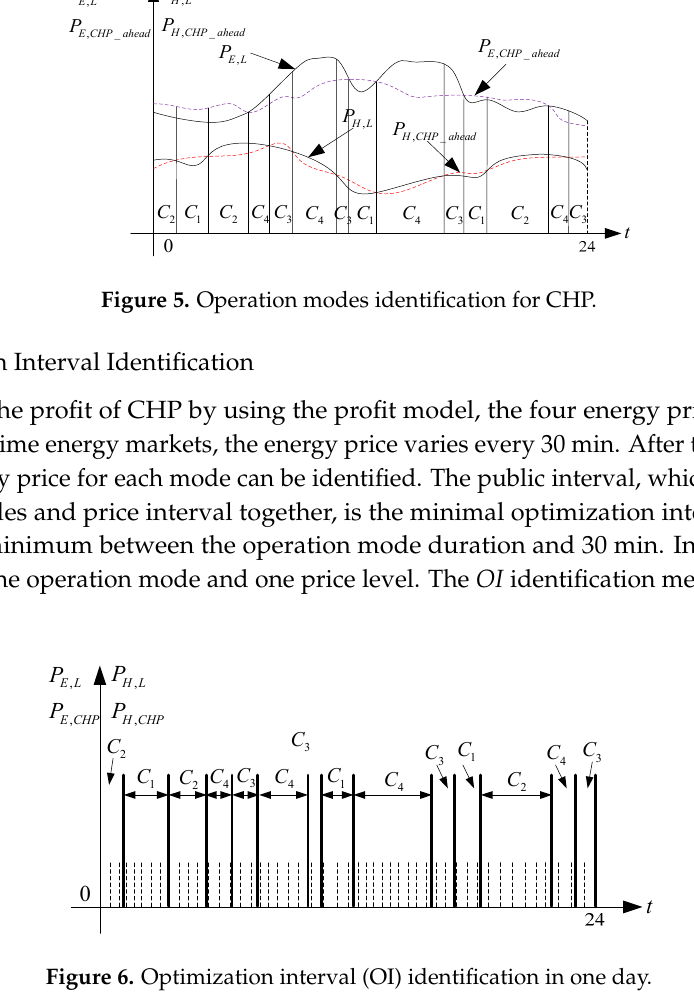
Figure 6. Optimization interval (OI) identification in one day.